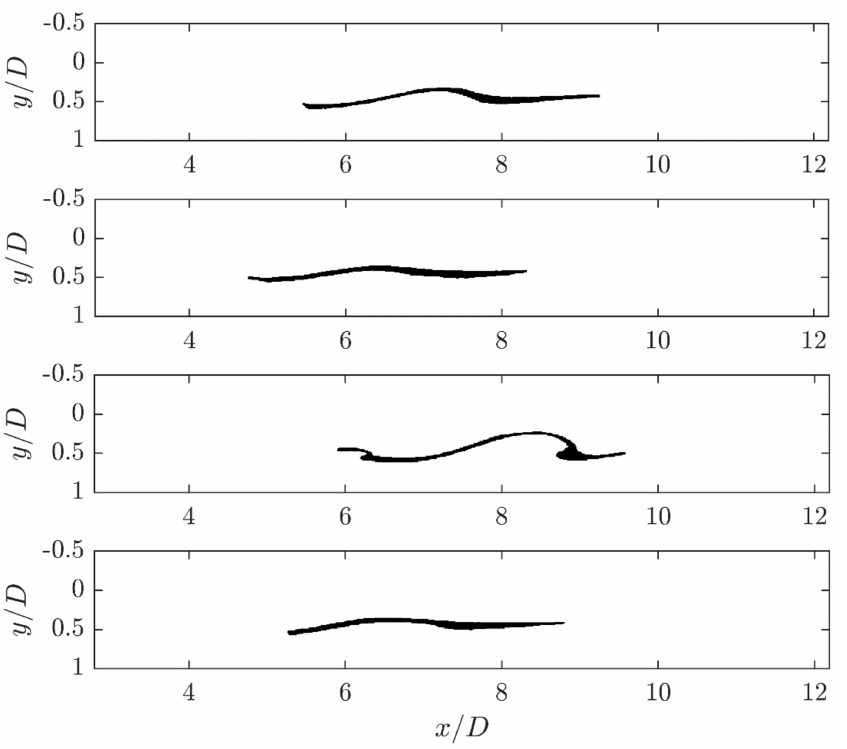
Figure 19. Visualization of eccentric injected primary droplets deformed by Kelvin-Helmholtz vortices in the meso scale at Re = 2000.